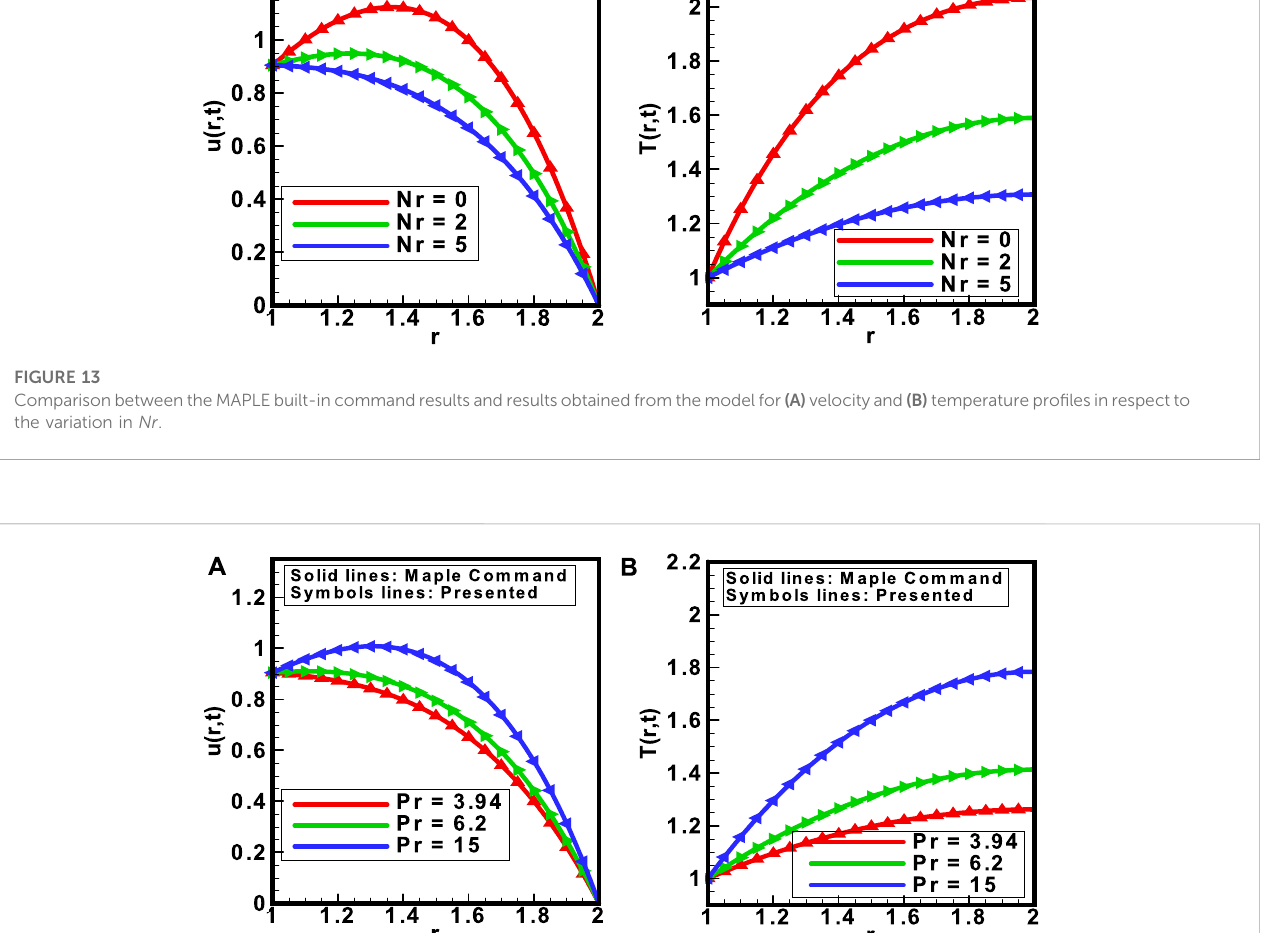
FIGURE 14 ComparisonbetweentheMAPLEbuilt-incommandresultsandresultsobtainedfromthemodelfor (A) velocityand (B) temperaturepro fi lesinrespectto the variation in Pr